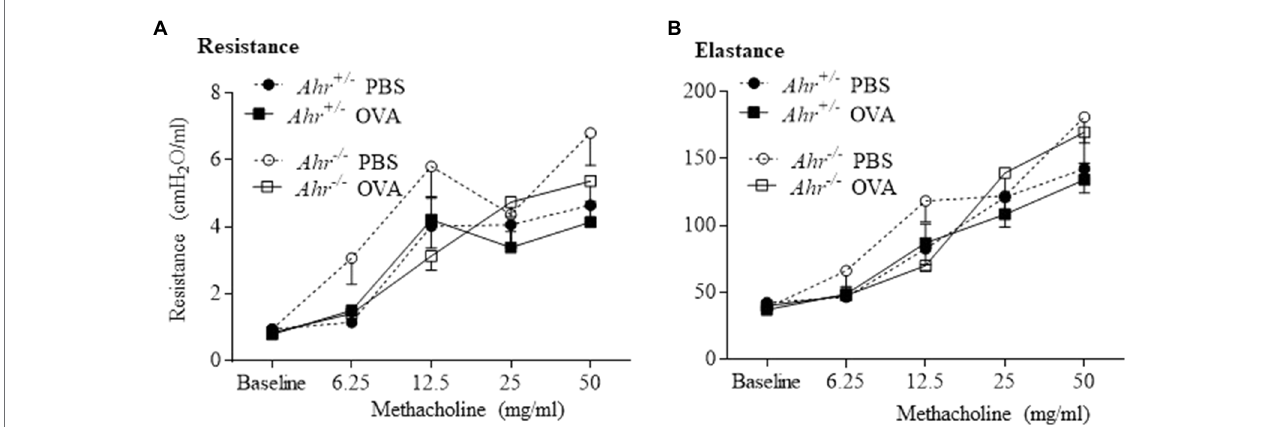
FIGURE 5 | Aryl hydrocarbon receptor does not influence lung function in the allergic asthma model. Lung mechanics were evaluated by flexiVent. There was no significant difference between OVA-immunized Ahr − / − and Ahr+/ − mice in any of the parameters evaluated including resistance (A) and elastance (B) . Results are expressed as the mean ±